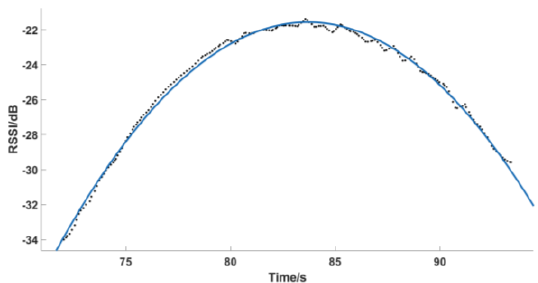
Figure 11. Least squares fitting.